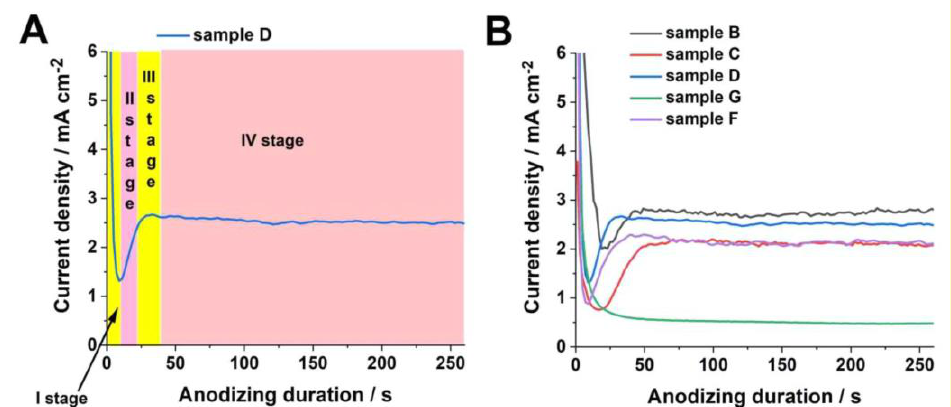
Figure 3. Current density vs. time curves recorded during anodic oxidation of metallic tungsten with marked different stages of anodization ( A ). Current density vs. time curves recorded during anodization of W at different conditions ( B ).